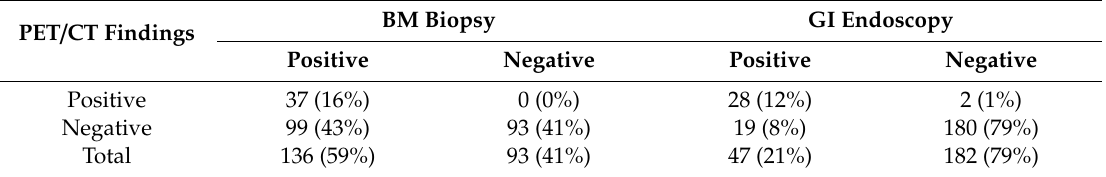
Table 2. Agreement between 18F-FDG PET / CT and BM biopsy and GI endoscopy findings. PET / CT